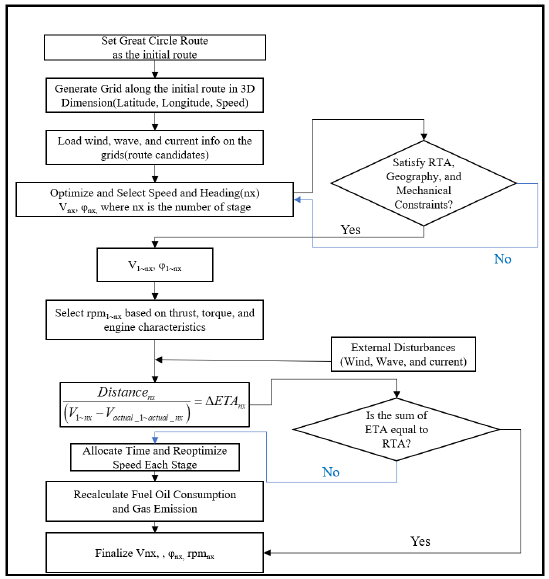
Figure 10. Schematic diagram of the modified fixed power control.